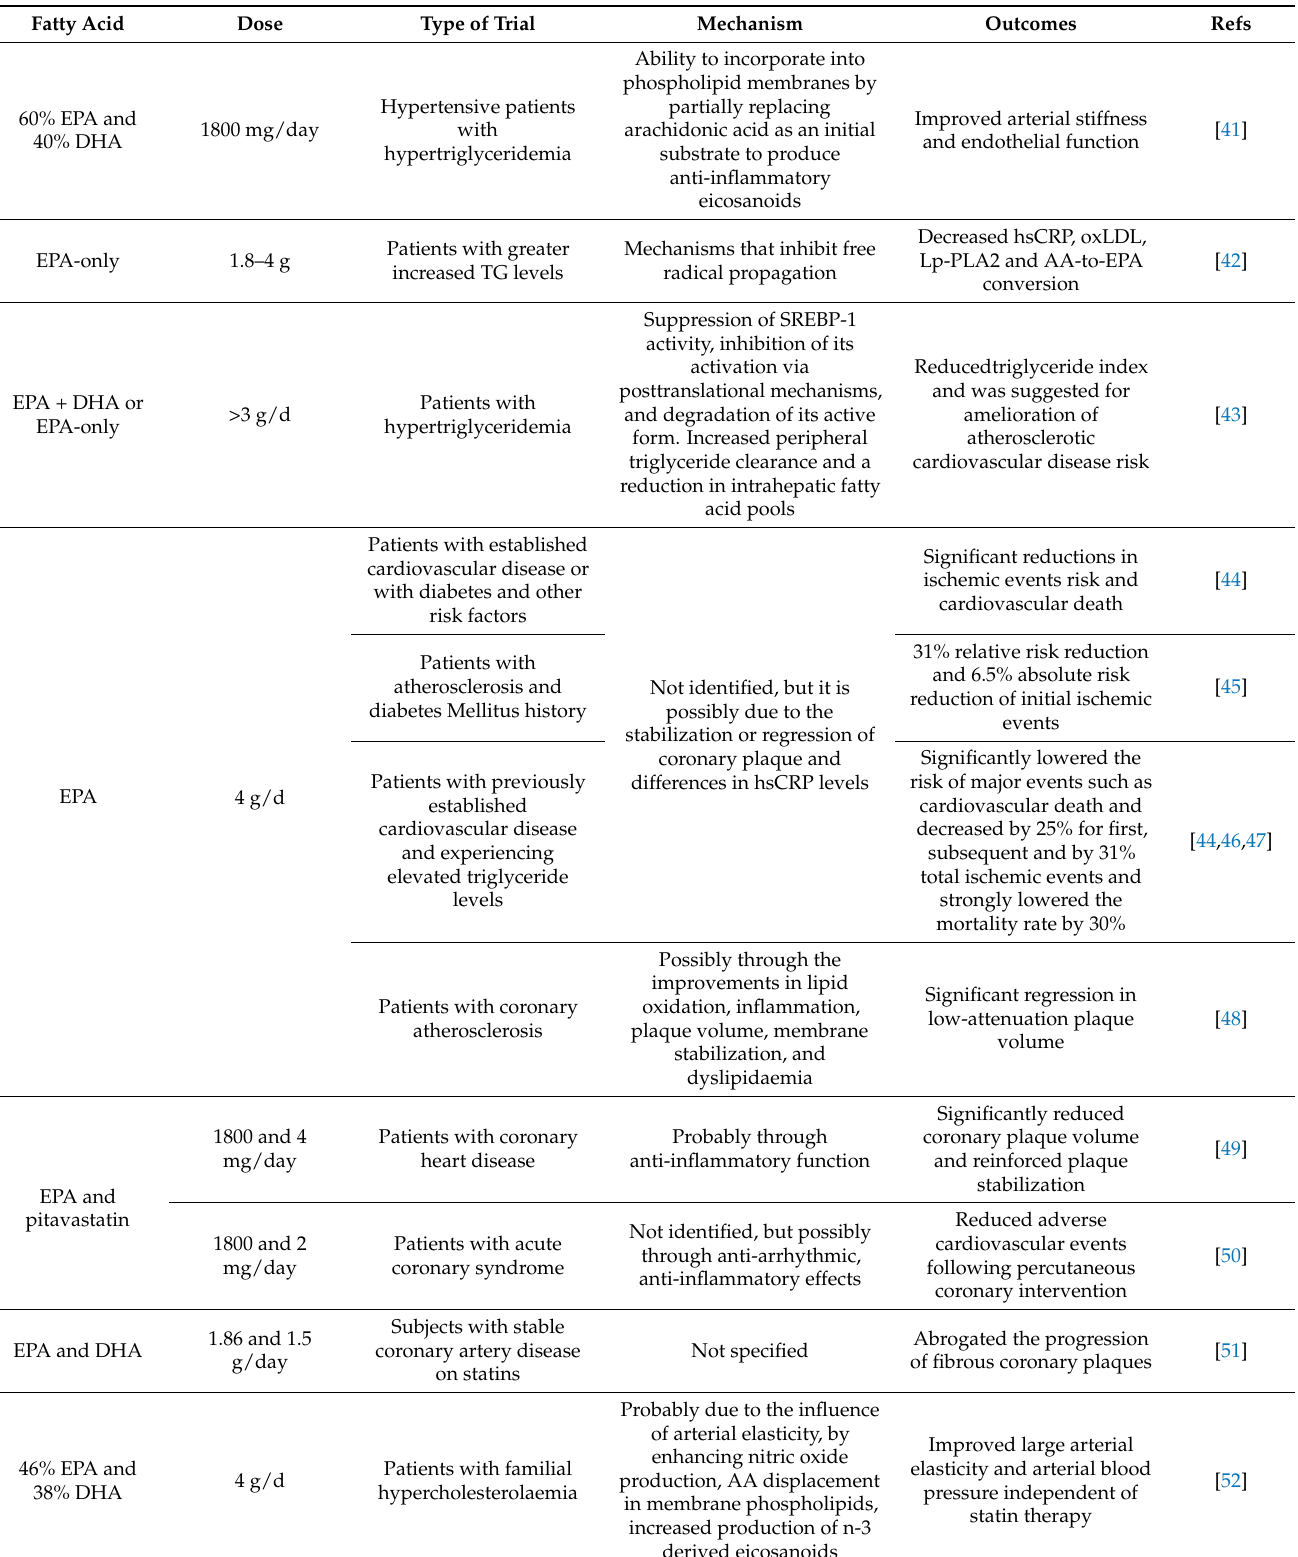
Table 1. Essential PUFAs associated with the relief and improvement of CVD clinical